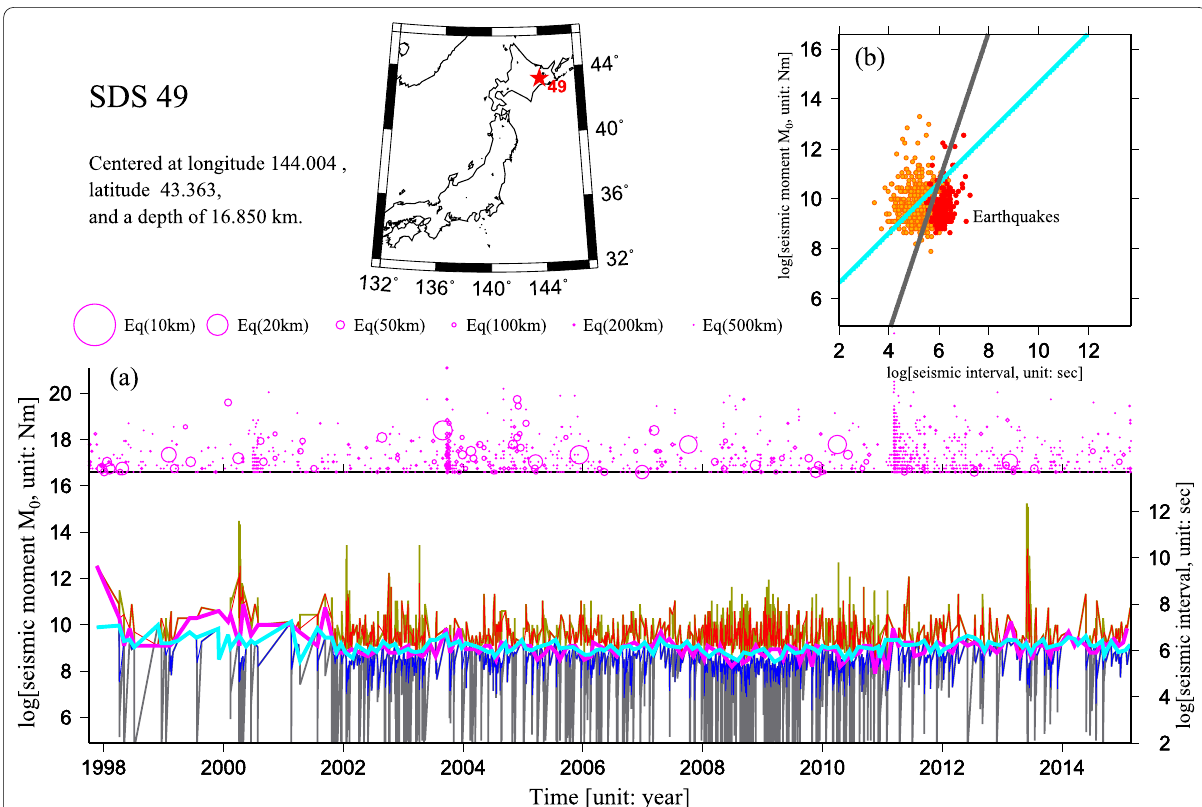
Fig. 2 a The relationship between the logarithm of the seismic moment (the green curve indicates the total catalog, the red curve indicates the DMSI catalog, and the pink curve indicates the MMSI catalog following the left vertical axis, log 10 [Nm]) and the logarithm of the seismic interval (the gray curve indicates the total catalog, the blue curve indicates the DMSI catalog, and the cyan curve indicates the MMSI catalog following the right vertical axis, log 10 [s]), with Mw < 5 during the time interval from October 1, 1997 to February 28, 2015. The pink curve correlates well with the cyan curve. The pink open circles in the upper part indicate contemporaneous peripheral earthquakes (Mw > 5) within a distance of 500 km and with a moment following the left vertical axis, log 10 [Nm]. The circle radii are proportional to the reciprocals of the hypocenter distances from the sphere center. b The relationship between the values of MMSI (red circles), DMSI (orange circles) and the seismic moments. The cyan line indicates the predicted Mo–SI distribution following Eq. 3, while the gray line indicates the predicted Mo–SI distribution following Eq.